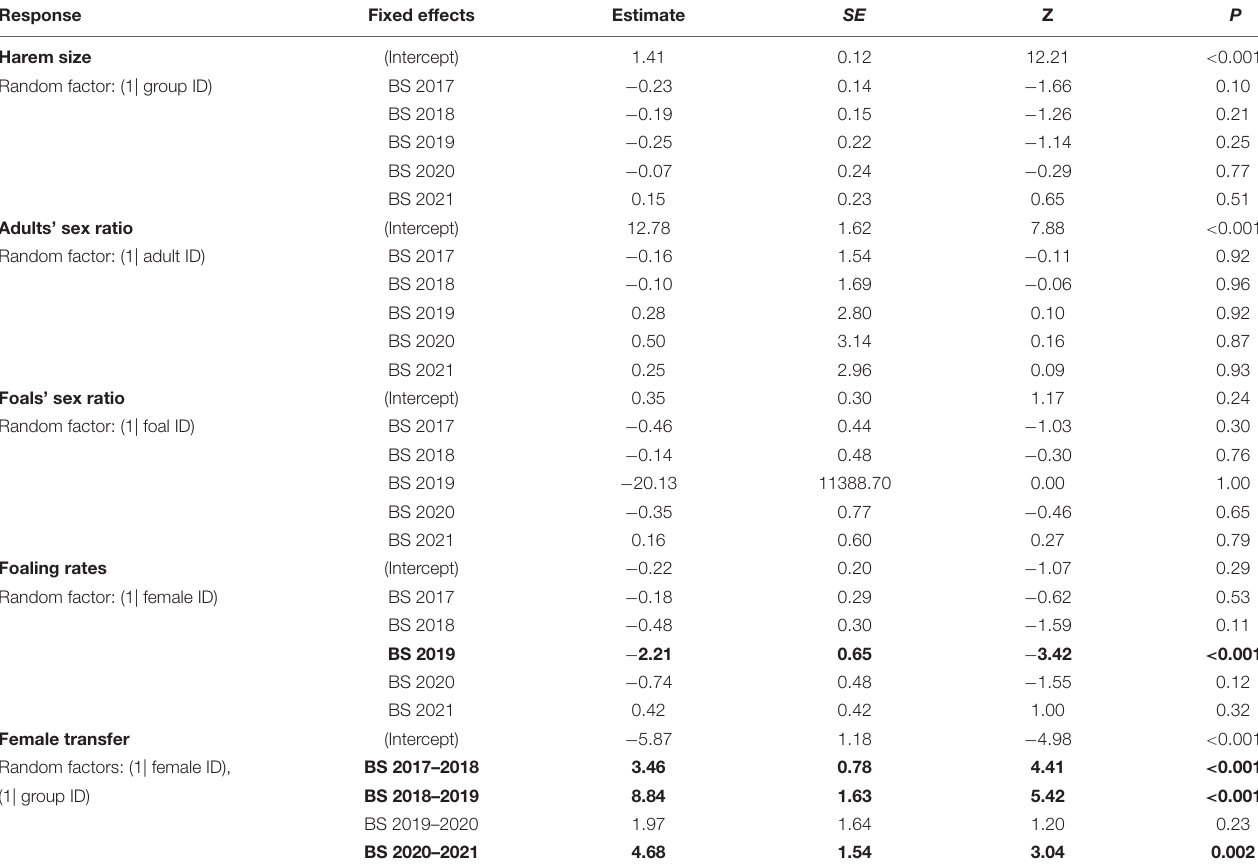
TABLE 3 | Summary statistics for five separate generalized linear mixed models that investigated the effect of breeding season (BS) on harem size, adults’ sex ratio, foals’ sex ratio, foaling rate and female transfers. Response Fixed effects